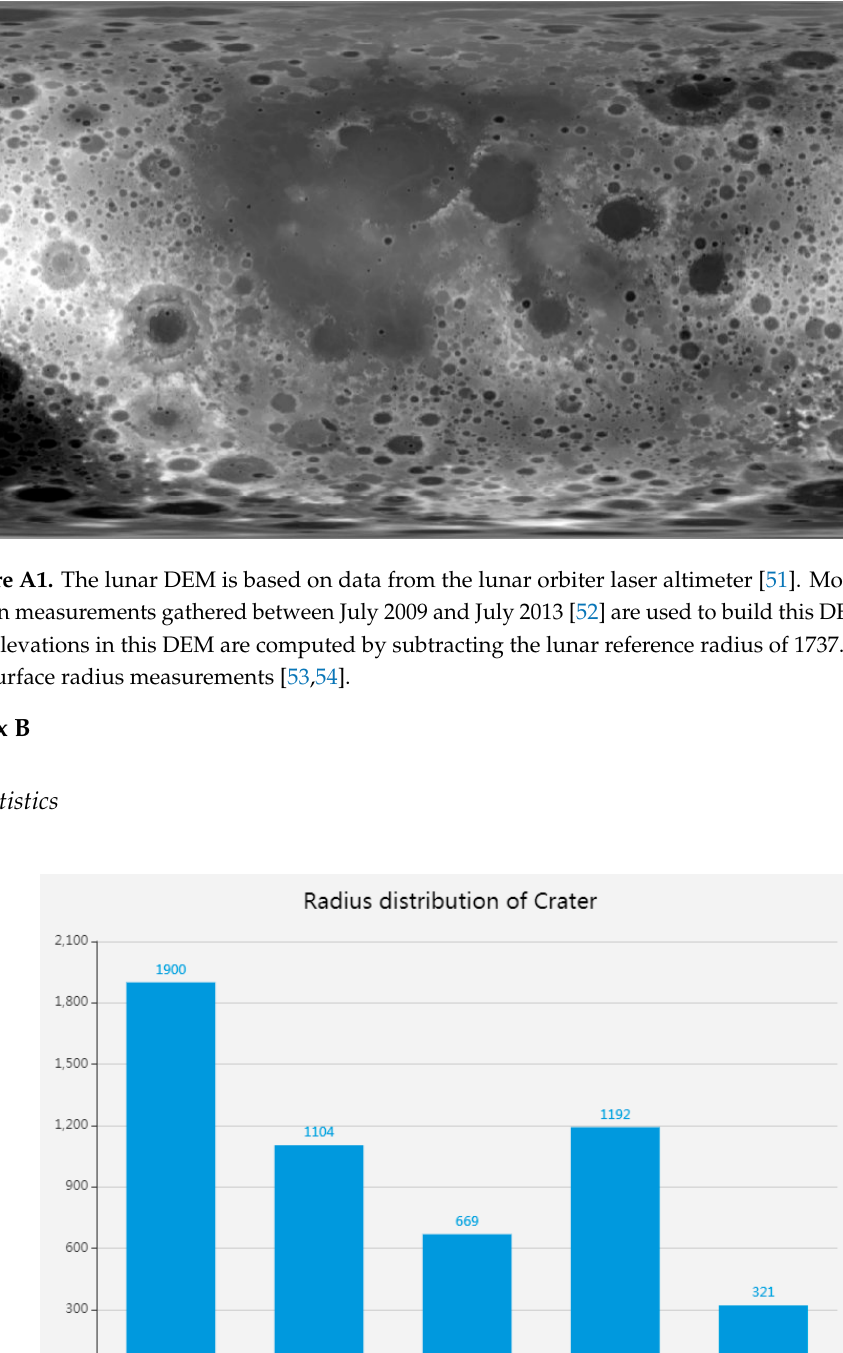
Figure A2. Distribution of large lunar craters (radius > 20 km) made by Head [25]. The total number of impact craters is 5186.